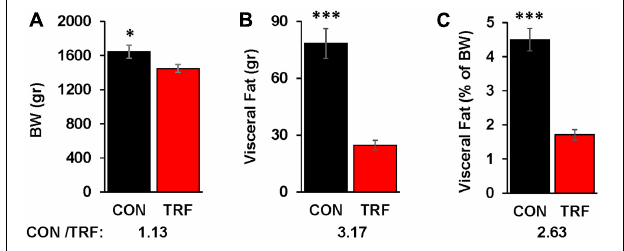
FIGURE 2 | The effect of the TRF treatment on visceral fat accumulation. (A) Live body weight (BW) in the control (CON) and TRF hens of 14 randomly selected birds from each group at 86 WOA. (B) Visceral fat accumulation of the birds in (A) . (C) Percent visceral fat of live body weight [based on the data in (A,B) ]. Ratio of values from control versus TRF-treated birds is shown at the bottom of each panel. Vertical lines represent scanning electron microscope. ∗ , ∗∗∗ P < 0.05 and 0.001, respectively.